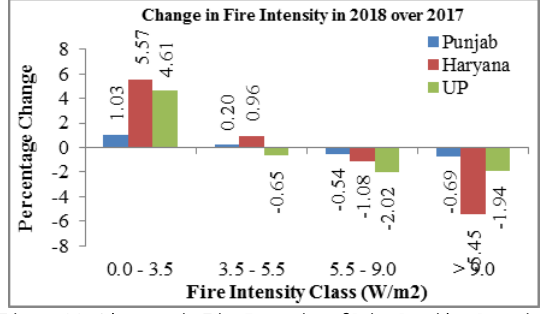
Figure 11. Changes in Fire Intensity of Rice Residue Burning in 2018 as Compared to